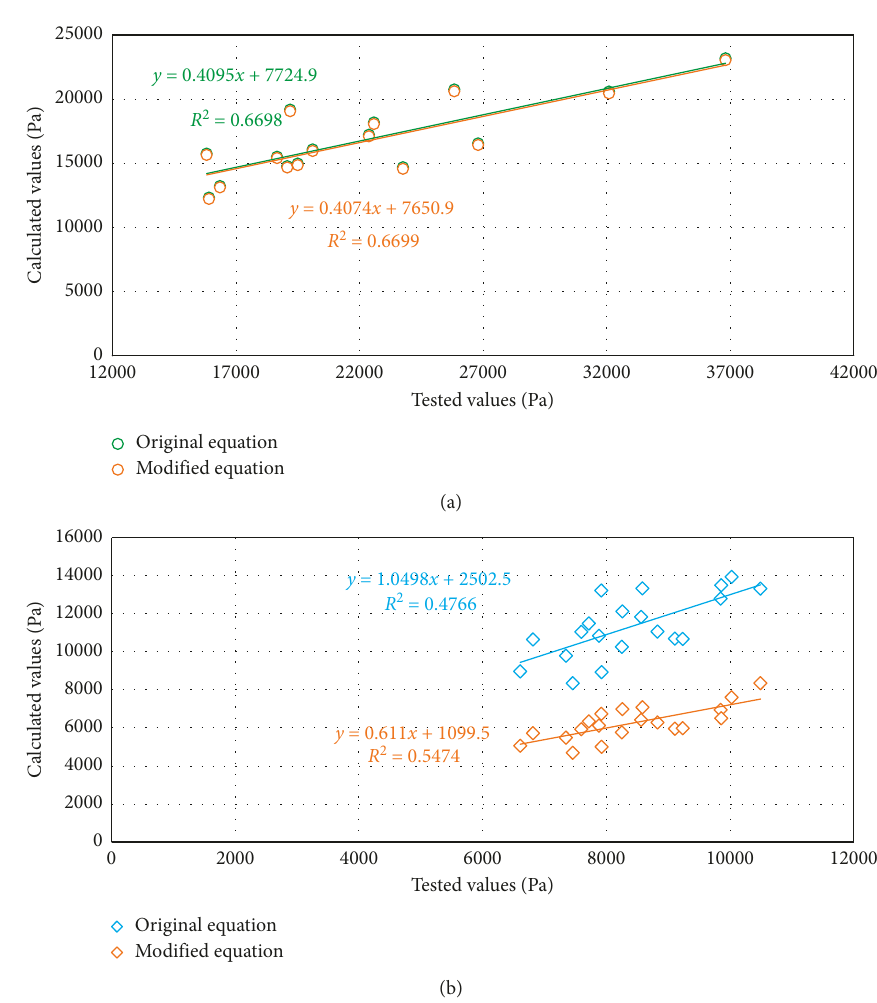
Figure 7: Correlation of overpressure between calculated values and tested values. (a) Zone I. (b) Zone III.